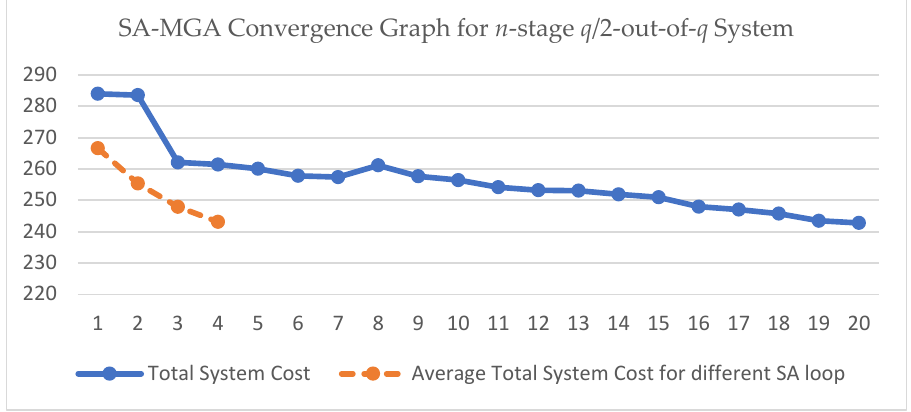
Figure 15. The convergence graph of the n -stage k -out-of- q system for the SA–MGA combined method.